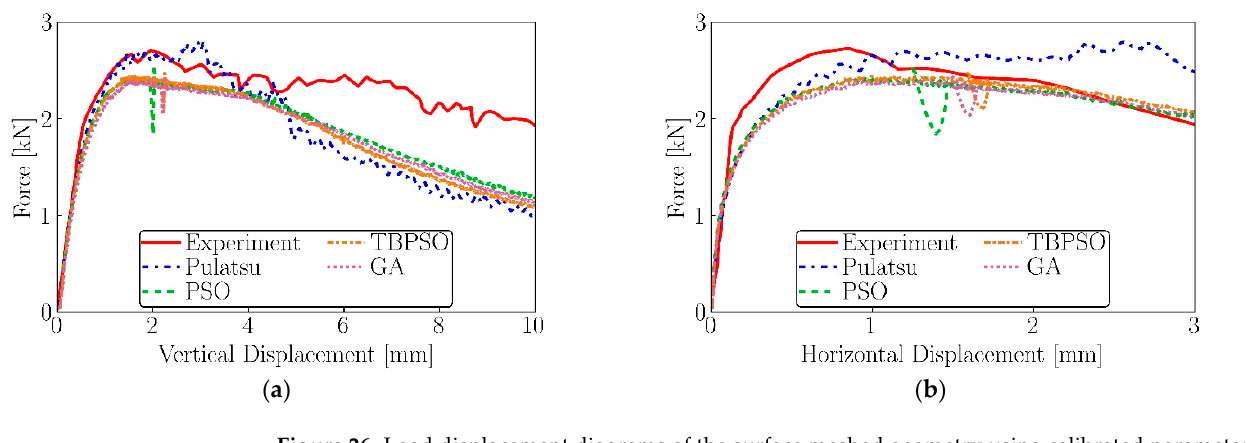
Figure 26. Load displacement diagrams of the surface meshed geometry using calibrated parameters with objective function 2 at reduced (5 × 10 − 4 m/s) loading plate velocity: ( a ) vertical displacement, ( b ) horizontal displacement.